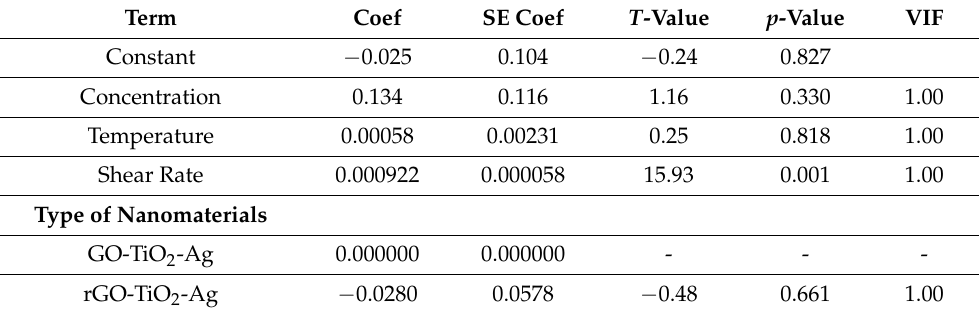
Table 7. Coefficient table (shear